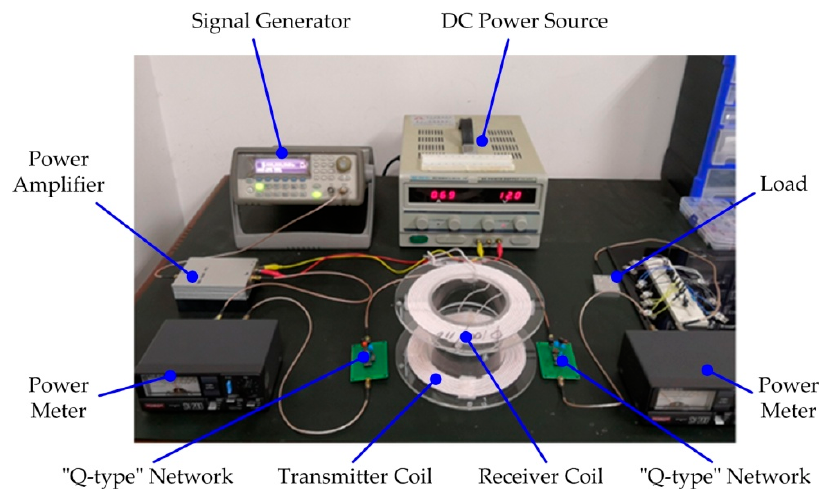
Figure 8. The modified WPT system.